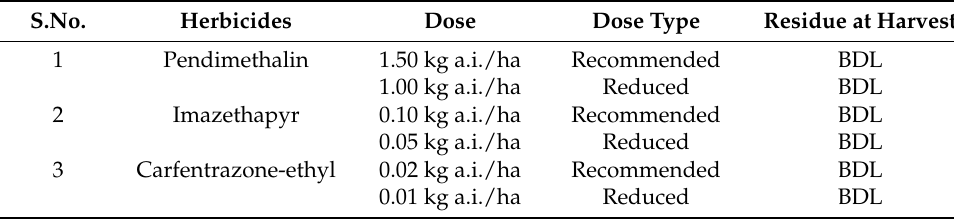
Figure 6. Chromatograms obtained by 1 ppm standard solution ( A ), and soil samples with no detectable herbicide ( B ) in the MRM mode showing the three transitions used for the quantification and confirmation of the contaminated sample. Table 5. Herbicide residues in